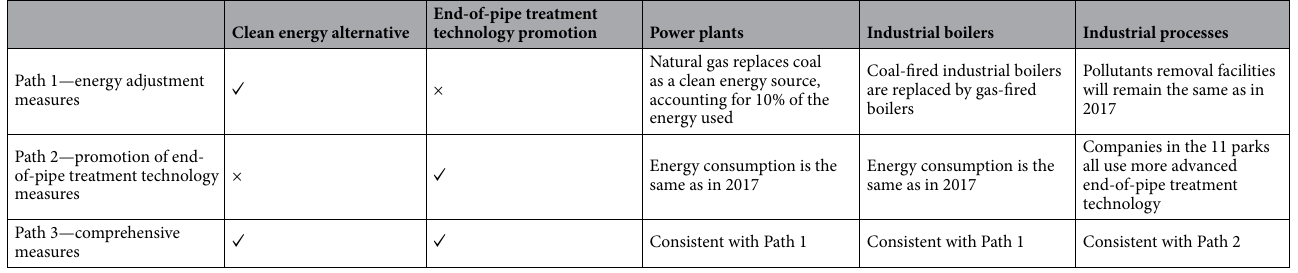
Table 1. Definitions of three reduction paths in this